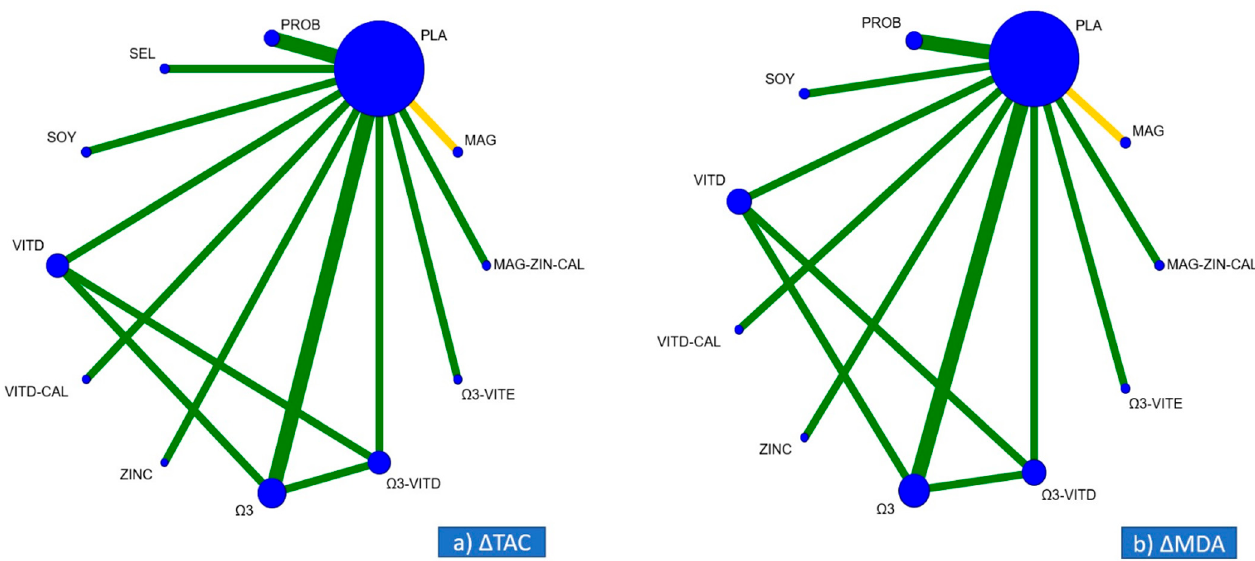
Figure 2. Network plots for the primary outcomes of ( a ) Δ TAC (changes in total antioxidant capacity) and ( b ) Δ MDA (changes in malondialdehyde). Interventions are represented by nodes and head-to-head comparisons with edges. The size of the nodes is proportional to the number of the patients, while the thickness of the edges is proportional to the number of studies. The color of the edges represents the average risk of bias for each head-to-head comparison, green for low risk of bias, yellow for uncertain risk of bias, and red for high risk of bias.